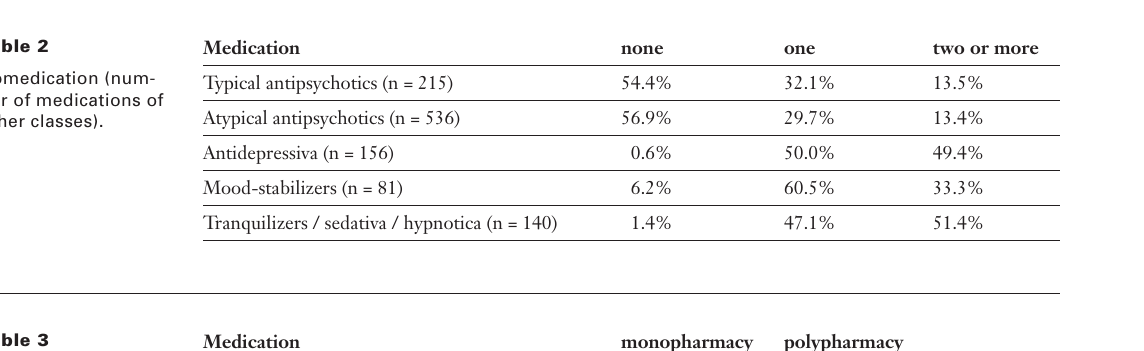
Polypharmacy (only for no